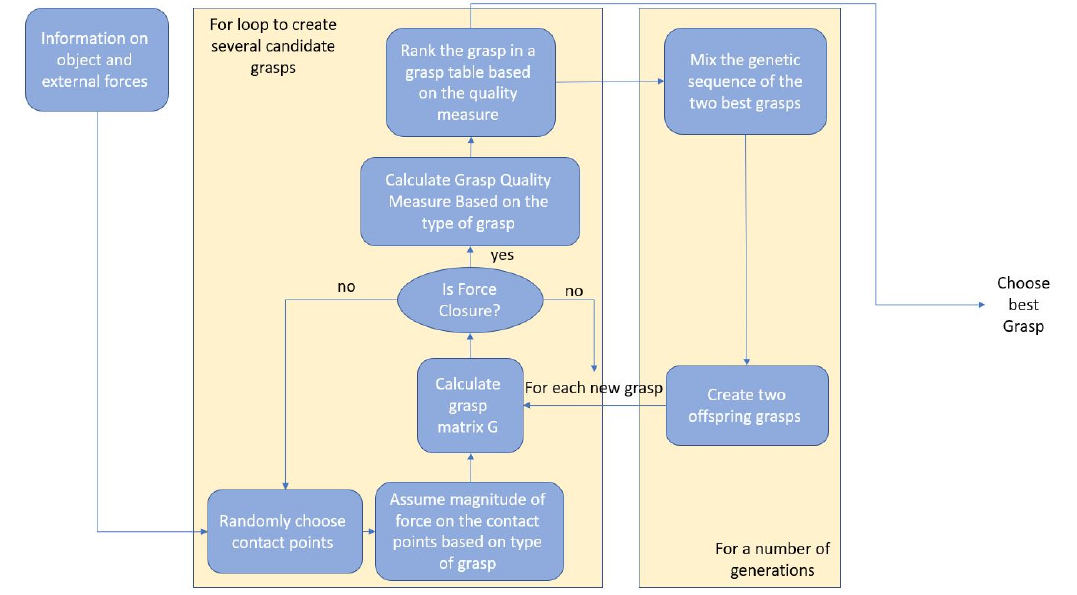
Figure 1. Optimal grasp finding